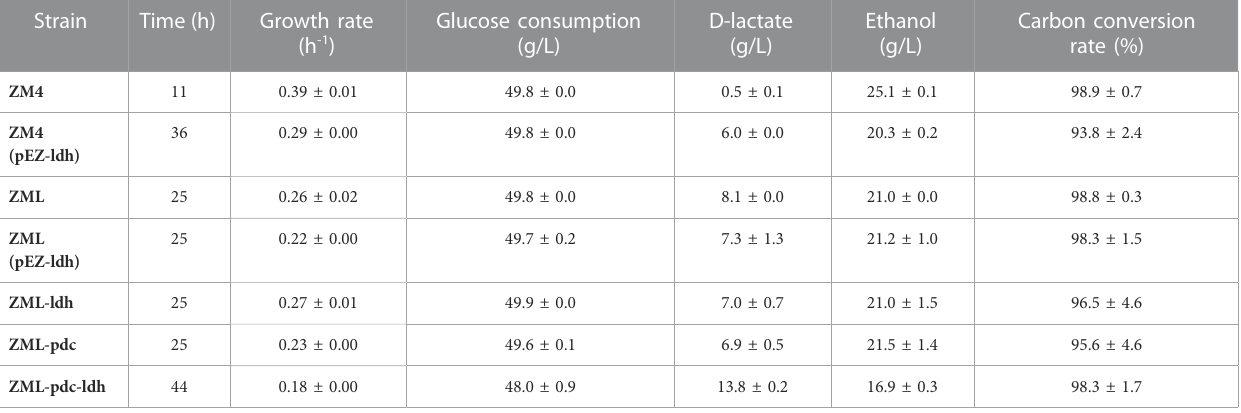
TABLE 1 Fermentation performance of the growth rate, glucose consumption, the yields of D-lactate and ethanol, as well as the carbon conversion rate of wild- type Z. mobilis ZM4 and its derivative strains of ZM4 (pEZ-ldh), ZML, ZML (pEZ-ldh), ZML-ldh, ZML-pdc, and ZML-pdc-ldh in RMG5. Strain